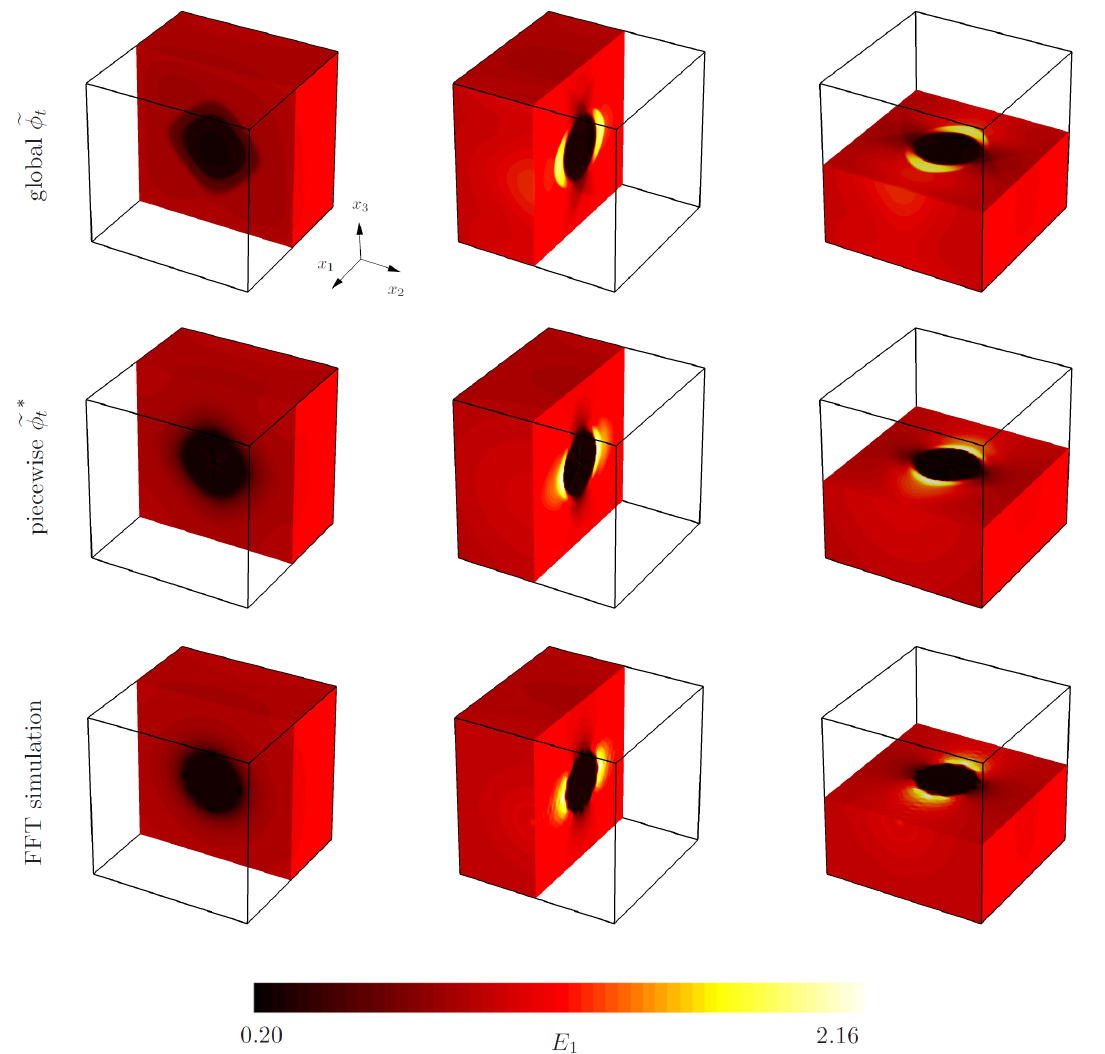
Figure 11. Contour plot of E 1 for a global and a piecewise-defined construction of the trial function as well as an FFT-based simulation for comparison. The results of the ANN simulations are close to the FFT-based simulation. The jump discontinuity is more distinct in the piecewise-defined approach compared with the global